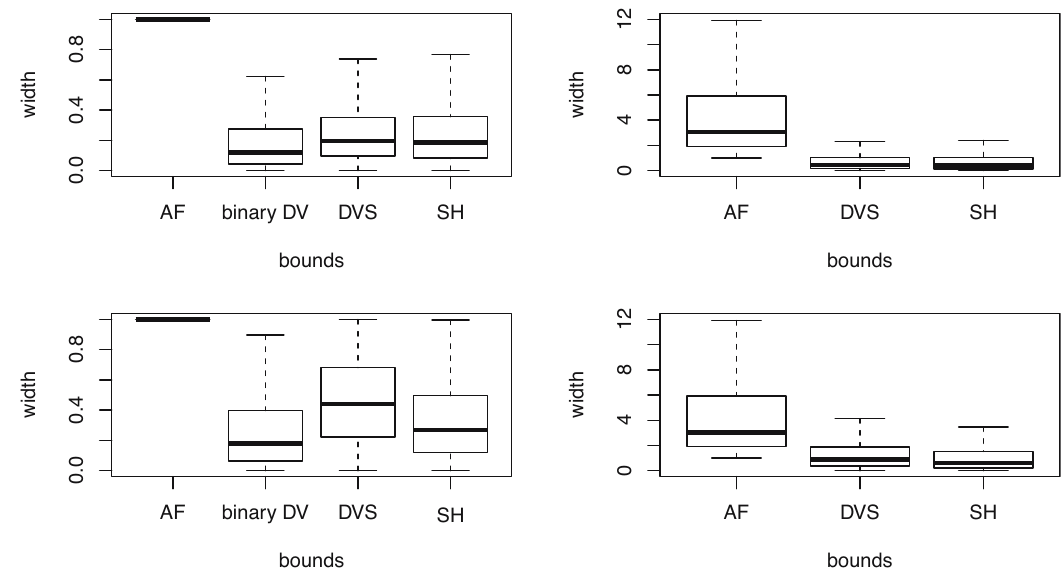
Figure 2: Width of the bounds for the causal risk di ff erence ( left panel ) and the causal risk ratio ( right panel ) , without and with parameter reduction ( top row and bottom row, respectively )